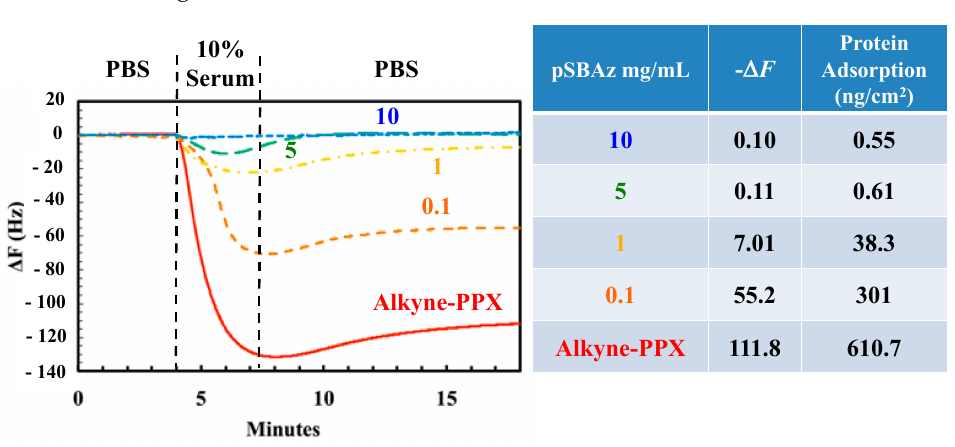
disks modified with Alkyne-PPX and pSBAz at 0.1, 1, 5, or 10 mg/mL. 10% FBS flowed through the QCM chamber, followed by flowing PBS to remove unbound proteins until the frequency reached equilibrium. The amounts of adsorbed proteins were determined from frequency changes, according to the Sauerbrey equation.